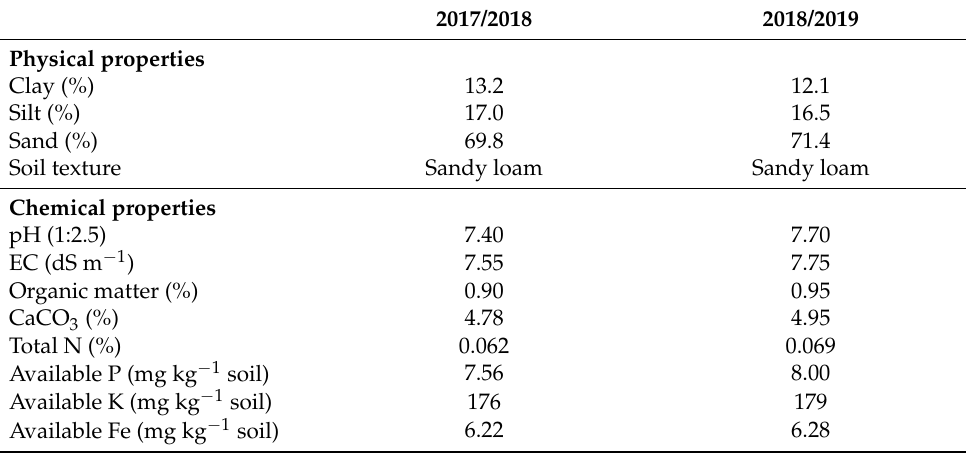
Table 2. Physical and chemical properties of soil before the field